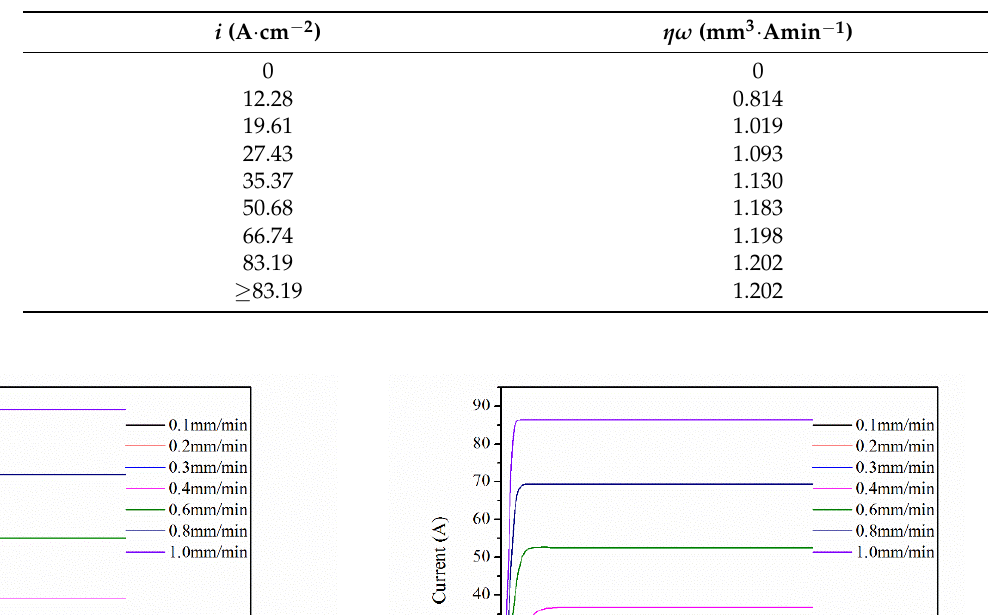
Table 2. ηω - I of 304SS.